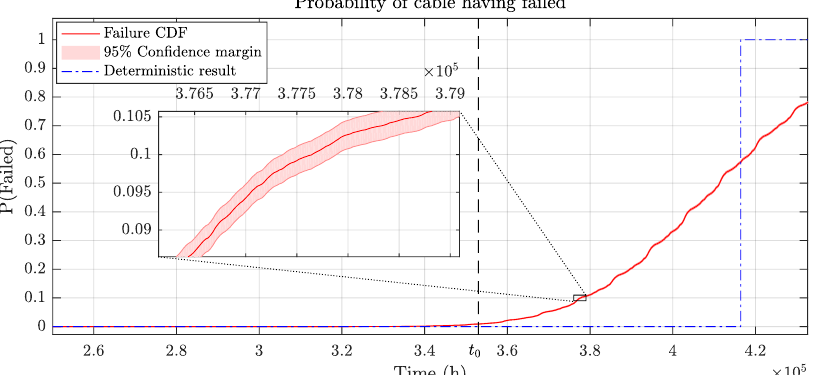
Figure 24. FPGA-based results considering uncertainties: σ η = 1.0%, σ o = 0.25%, σ p = 5%, λ = 2.31 × 10 − 4 h − 1 , and τ Inc = 6h.